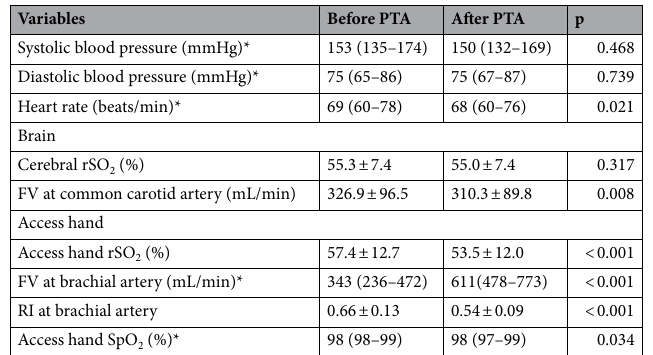
Table 1. Comparison of clinical parameters between before and after PTA. Continuous data are presented as mean ± standard deviation. rSO 2 regional oxygen saturation, SpO 2 saturation of percutaneous oxygen, PTA